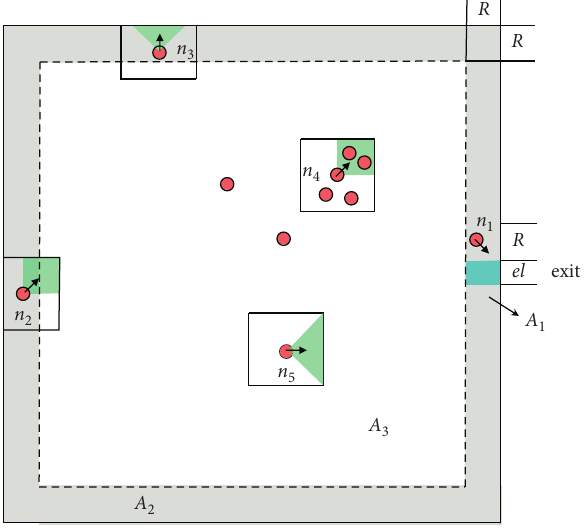
Figure 7: Area division of evacuation space with emotion perception.